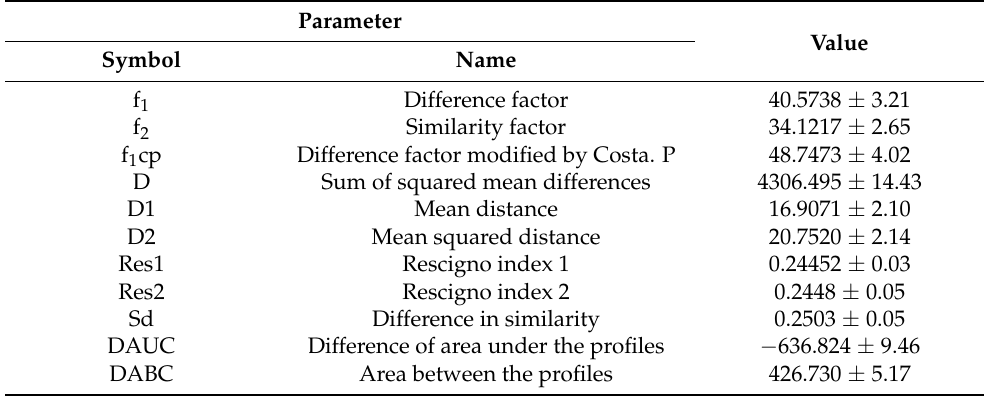
Table 2. DDSolver parameters for evaluating the differences between RLDL and free RXF dissolution